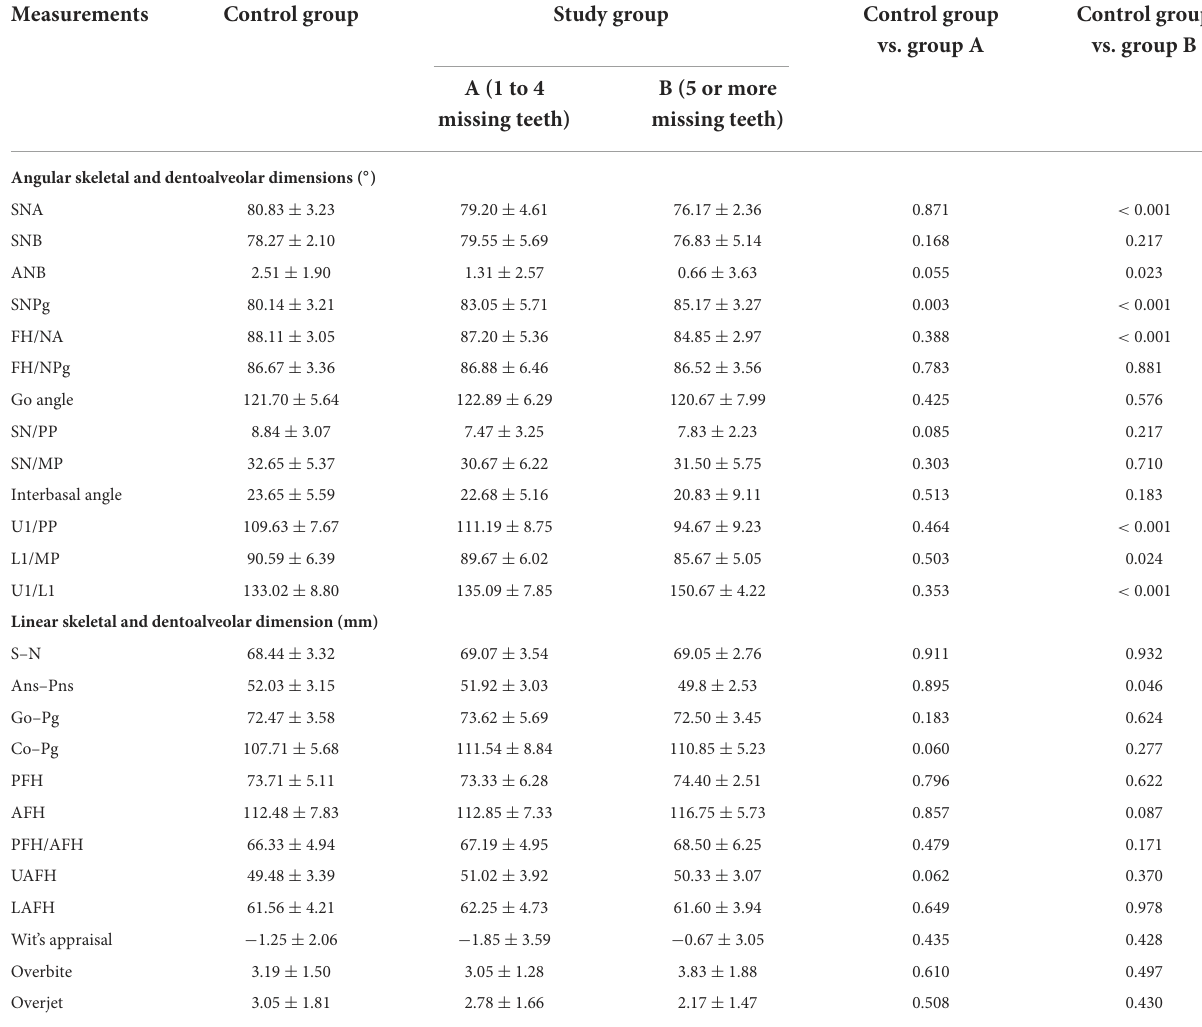
TABLE 6 Comparison of the skeletal cephalometric means and standard deviation (SD) between the control and study groups.